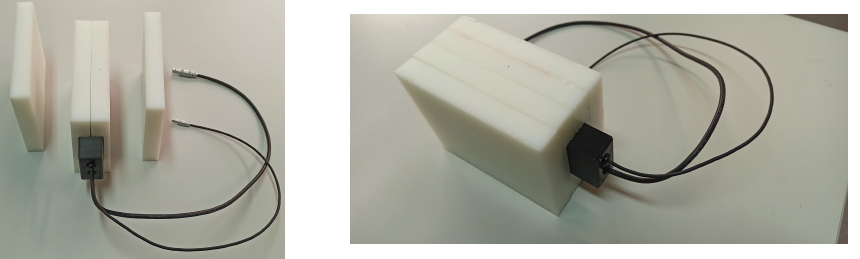
Figure 2. EJ-426HD detector inserted in a modular HDPE moderator with 7 cm thickness (20 mm thickness sheets of 14.5 ×11 cm 2 cross-sectional area). Total weight: 1.2 kg.